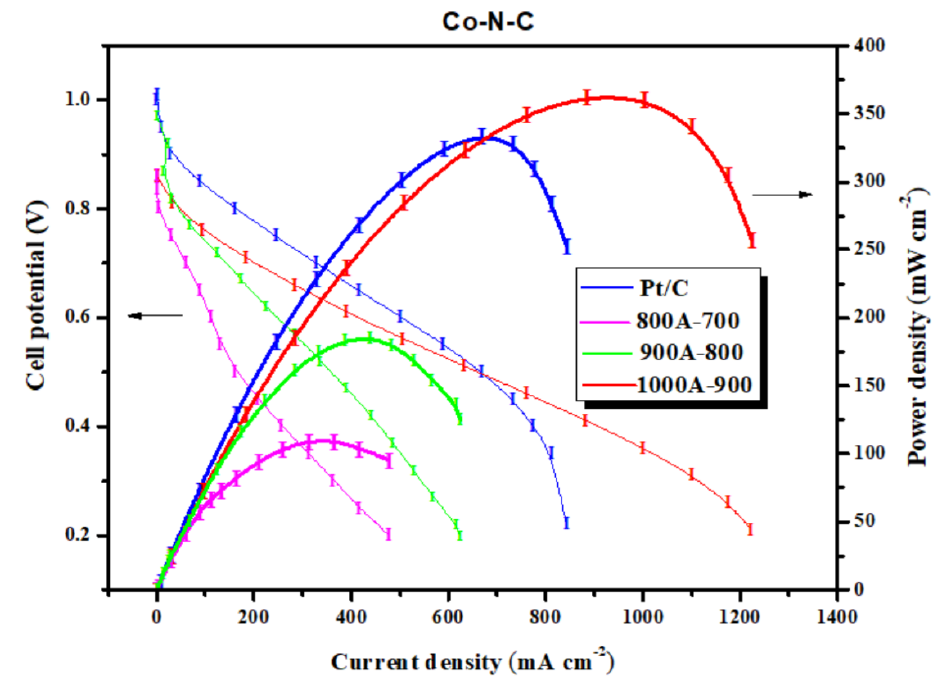
Figure 10. Power density and potential vs. current density of various single cells with Co-N-Cs and Pt/C as cathode catalysts.